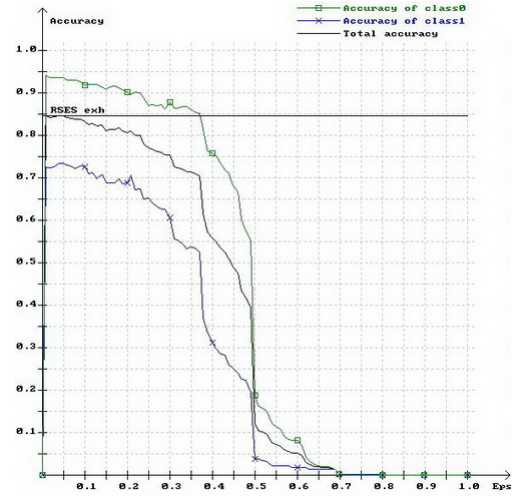
Fig. 4. Results for algorithm 5 v1, Best result for ε = 0 . 04: